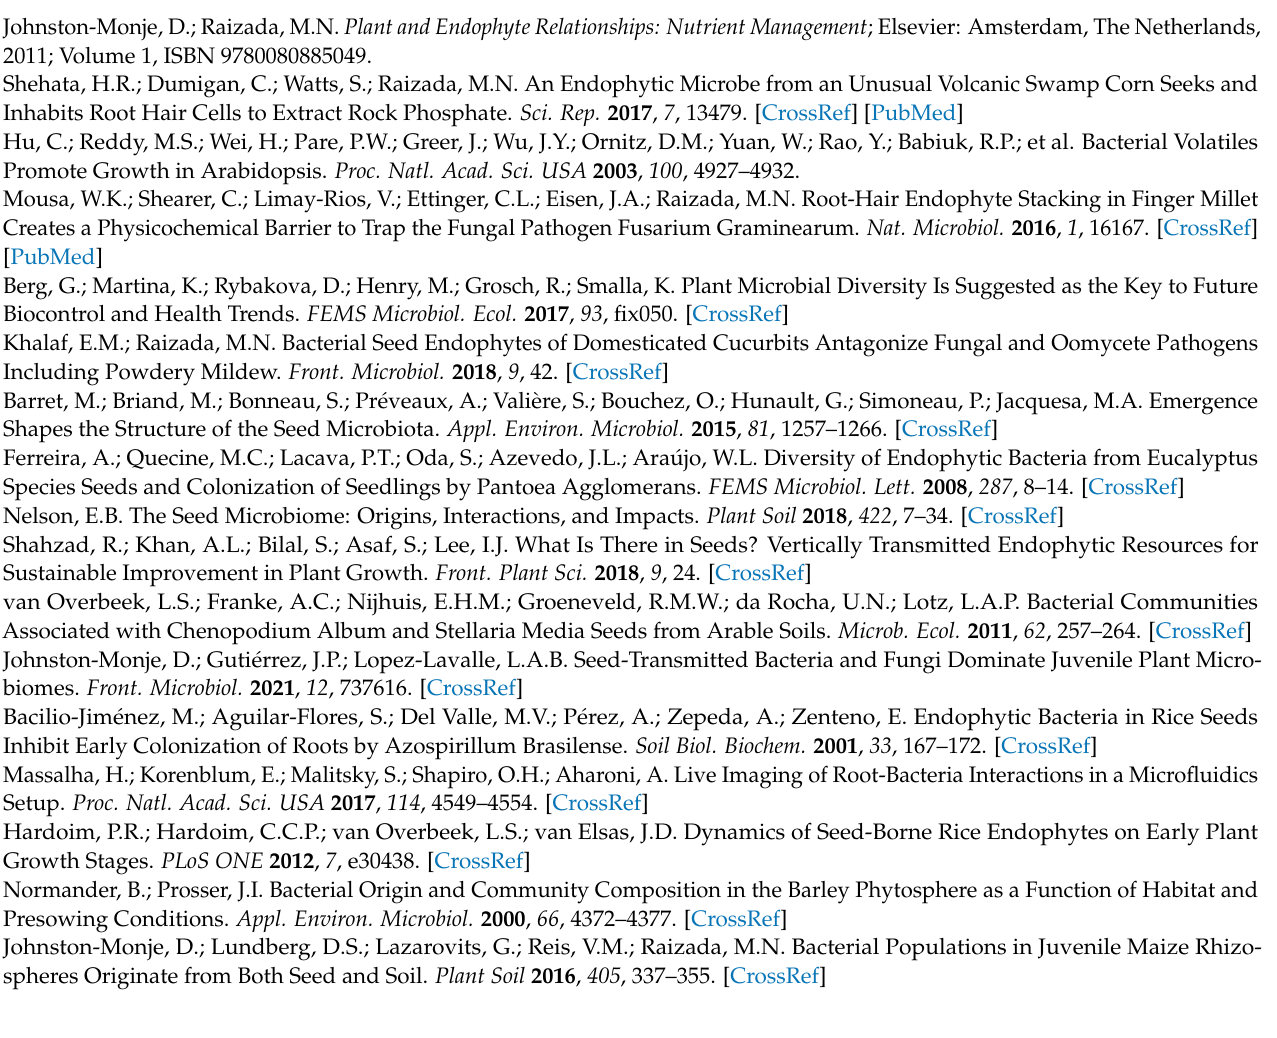
Supplementary Figure S1. 16S Phylogenetic Tree of Culturable Seed-borne Cannabis Seedling Endo- phytes Across Hemp X59 Generations. Supplementary Figure S2. Altair Seed-Associated